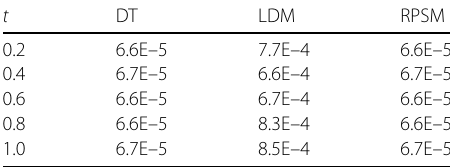
Table 6 Comparison of computing time for u